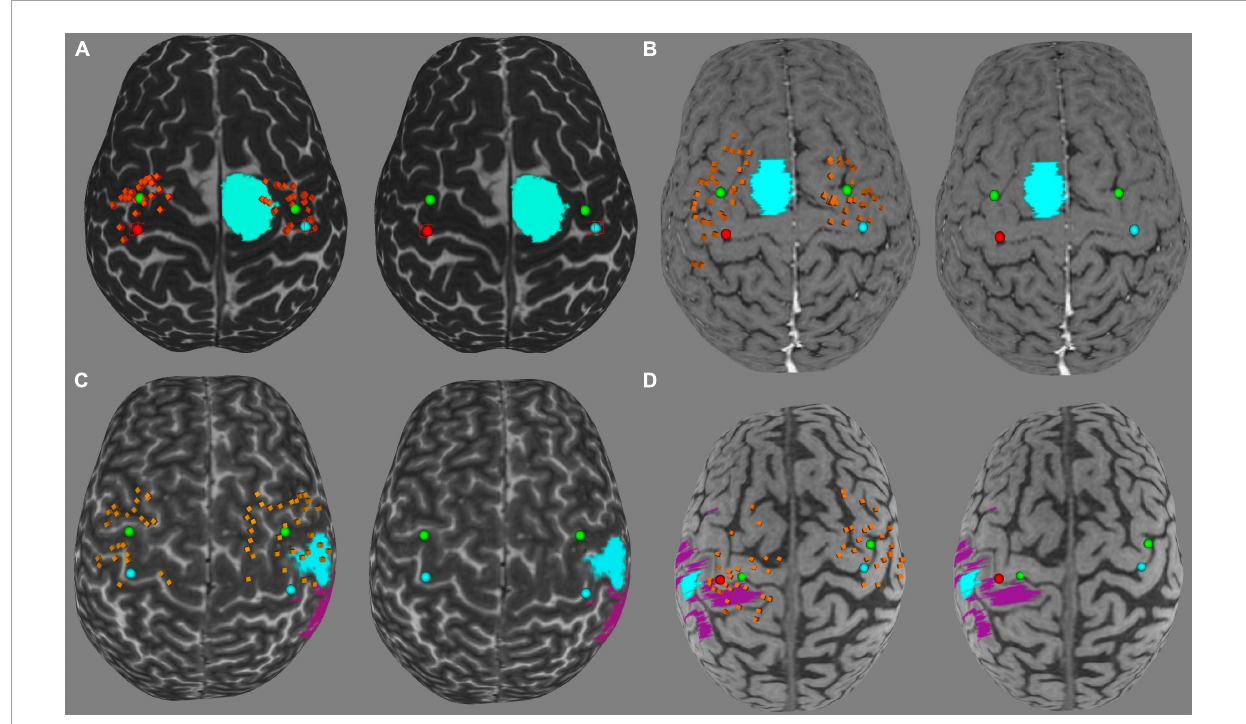
FIGURE7 Graphic representation of four patients (A–D) mapping. The red and blue dots are the reference points, green dots are CG points, orange points are positive motor points. Light blue areas are cortical tumor delimitation and purple areas represents edema. Example of qualitative analysis on the tumor hemisphere compared to the healthy hemisphere: (A) closing, Homogeneous; (B) lateral, dispersion, Heterogeneous; (C) distancing, Heterogeneous; (D) posterior, medial,